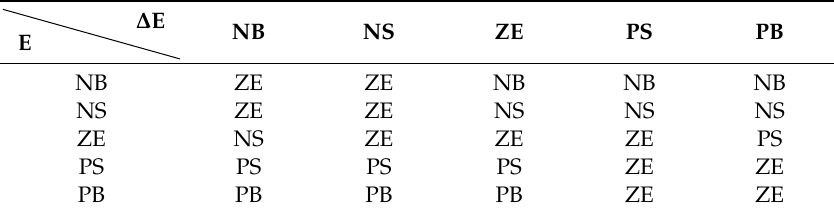
Table 2. Rule base for fuzzy